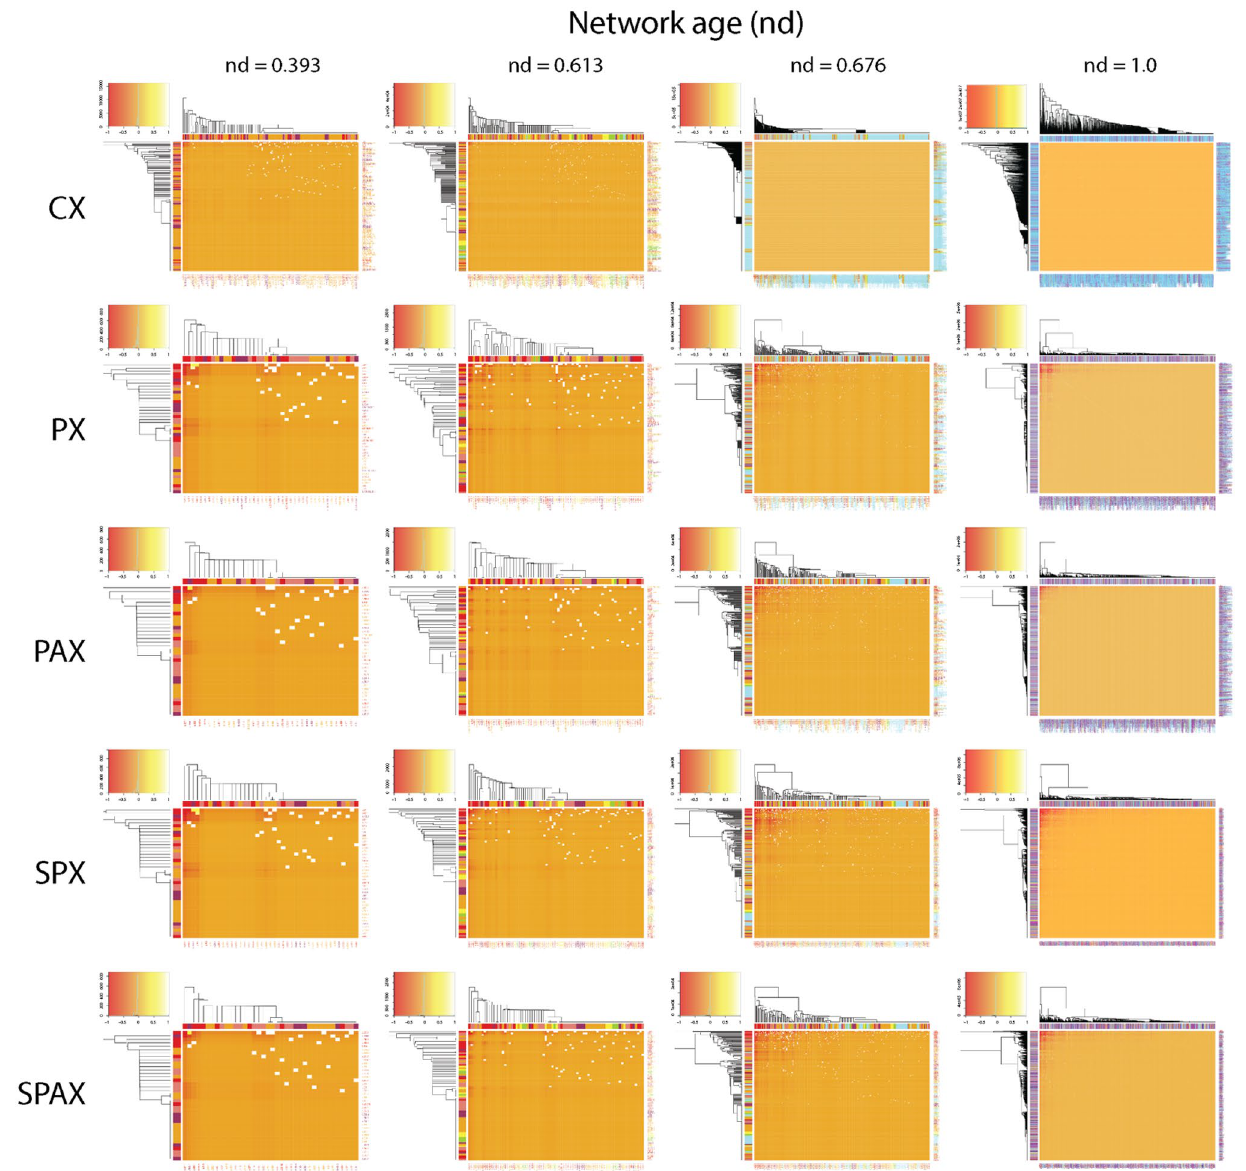
Figure 6. Evolution of modularity and hierarchical organization of networks over select events of the evolutionary timeline. NG age pairwise modularity values 65 , scaled by log10 of network-wide absolute modularity values, were used as input for the calculation of Euclidean distance matrices 87 , which were visualized as heatmaps. Heatmap tiles represent modular strength between any two architectures relative to the respective strength of their linkages to other architectures of the network. The embedded dendrograms that define the order of rows and columns of the heatmaps were generated by hierarchical clustering of the distance matrices with the Ward’s minimum variance method 88 . The height of dendrograms represents dissimilarity between clusters while the clades show grouping rearrangements of architectures. The top-left insets depict frequency histograms of the heatmap modularity values scaled from − 1 to 1 (i.e. disassortative to assortative). The four panels describe growth of each evolving network (left-to-right). Network age corresponds to the middle approximate boundaries of the three evolutionary epochs of the protein world (Supplementary Fig. S2), i.e., end of ‘architectural diversification’ ( nd = 0.393), end of ‘superkingdom specification’ ( nd = 0.613), onset of the ‘big bang’ of domain organization at the start of ‘organismal diversification’ ( nd = 0.676); and the present ( nd = 1). Nodes were age-sorted ascendingly within clusters and labelled using standard SCOP nomenclature 9 . In the case of SPX and SPAX, nodes correspond to 1643 domains mapped to the entity set of 6162 architectures. The color-coding of bands and labels identifies the age of architectures (Supplementary Fig. S2). The relatively ’flatter’ heatmap and ’skewed’ dendrogram patterns of CX (typically at nd = 0.667 and nd = 1.000) are an artifact of unweighted distance matrices of CX, which contrast with the weighted ones of pairwise criterion-based networks. The most prominent clades correspond to the modules of the most ancient domain structures harboring the two major waves of architectural innovation. We also generated heatmaps of power-law control networks of corresponding sizes at the given time-events (Supplementary Fig. S10). When compared to the pairwise networks, the combined heatmap and dendrogram patterns of CX suggest a hidden switch from scale-freeness to modular behavior, eventually giving rise to hierarchical modularity with visible emergence of modules within